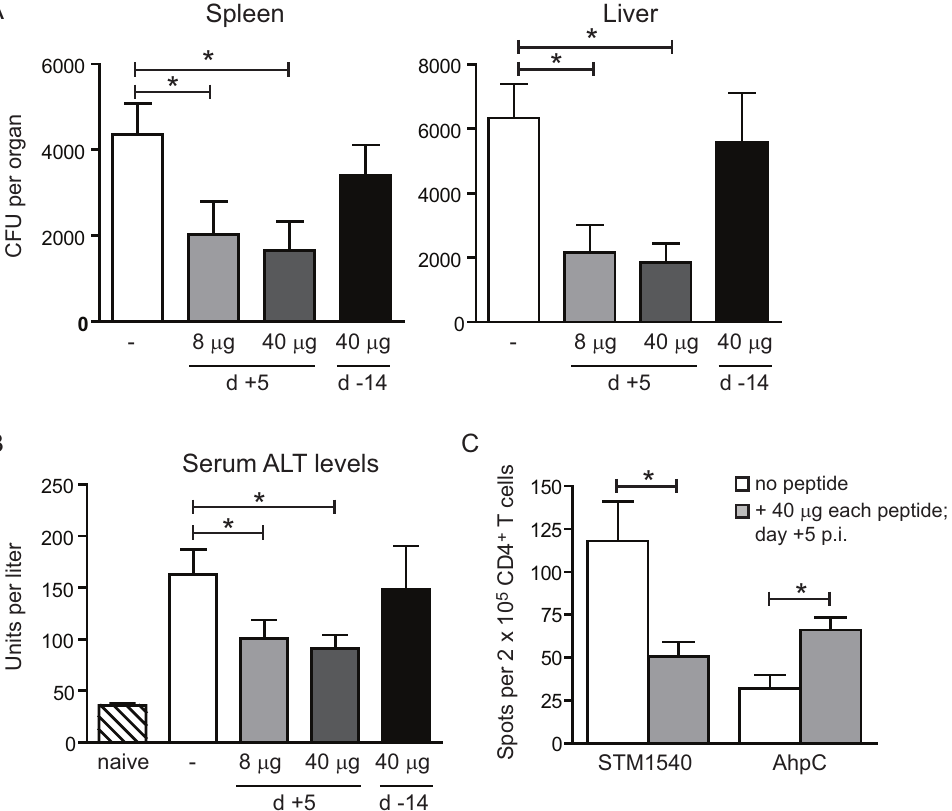
Figure 4. Vaccination with CD4 + T cell epitopes during ongoing infection reduces the burden of Salmonella disease. C57BL/6 mice were infected orally with 1 6 10 7 virulent Salmonella Typhimurium. Groups of mice (n=7–8) were vaccinated with a mixture of the peptides AhpC 154– 168 , EutC 243–257 , and STM1540 262–276 (8 m g ( , 5 nmol) or 40 m g ( , 25 nmol) of each peptide) at day 5 post-infection (therapeutic setting) or 14 days before Salmonella infection (prophylactic setting). Control mice received PBS without peptides. Mice were sacrificed at day 14 post-infection and (A) the Salmonella CFU were determined in spleen and liver, and (B) the ALT levels were determined in the serum. (C) CD4 + T cells purified from the spleens of the non-vaccinated mice and the mice vaccinated at day 5 post-infection (p.i.) with 40 m g of each of the peptides (AhpC 154–168 , EutC 243– 257 , and STM1540 262–276 ) were restimulated with dendritic cells that were loaded with the indicated Salmonella peptide epitopes. Graph shows the IFN- c + spots per 2 6 10 5 CD4 + T cells measured by ELISPOT assays. Statistical significance between the peptide vaccinated and non-vaccinated groups is indicated (Mann Whitney test, * p , 0.05). Naive mice (n=8) were used to determine the normal serum ALT levels. Bar graphs show mean and SEM. Experiments were performed twice with similar